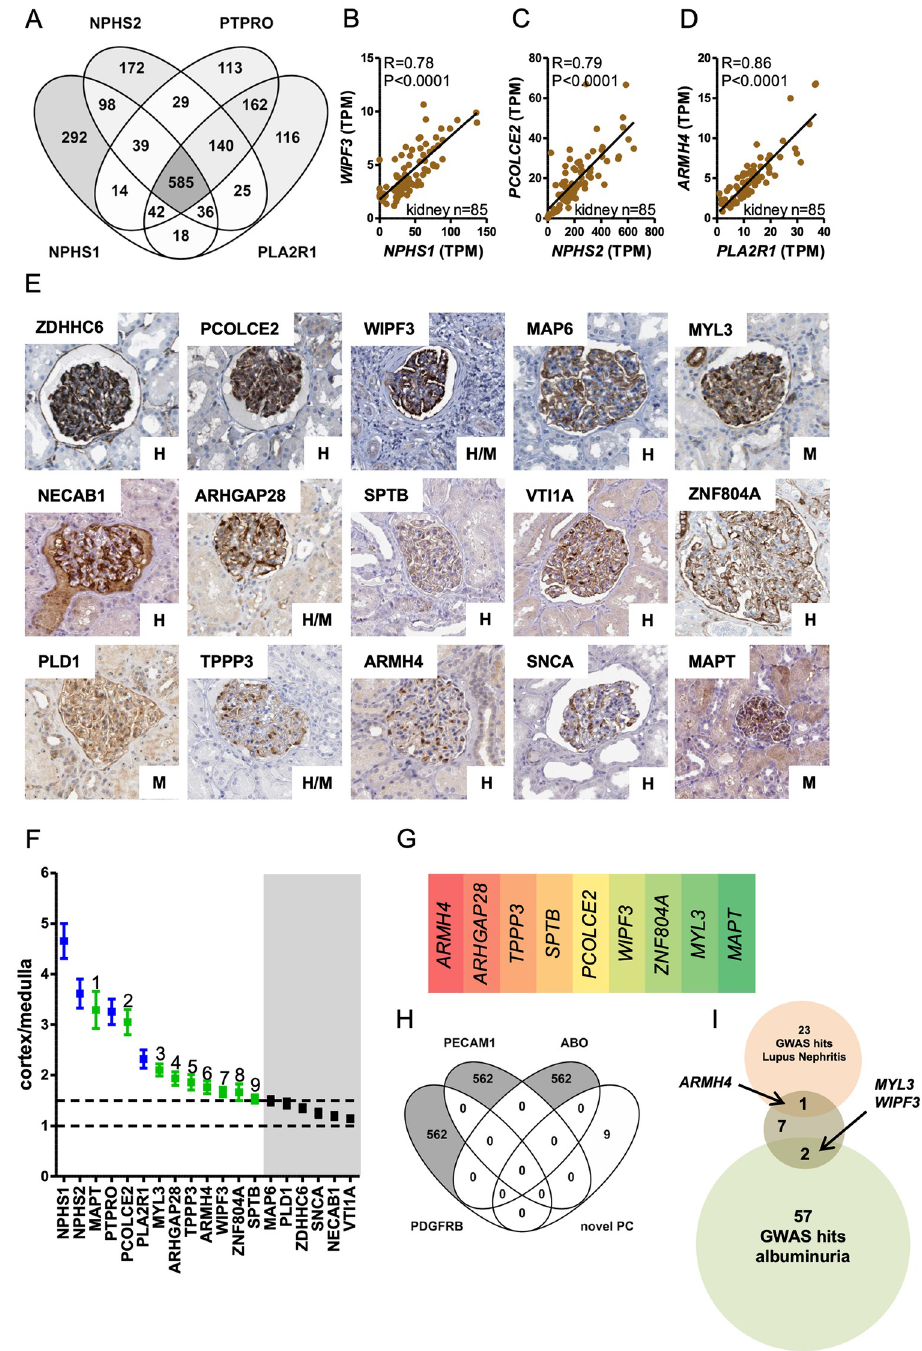
Fig 1. A multi-step computational strategy identifies human podocyte markers. NPHS1 , NPHS2 , PTPRO , and PLA2R1 were correlated with all other transcripts in kidney cortices from 85 individuals. A : overlay of 585 transcripts obtained by cross-referencing the top-ranking 1124 transcripts (2%) from each analysis. B—D : correlations between NPHS1 and WIPF3 , between NPHS2 and PCOLCE2 , and between PLA2R1 and ARMH4 . P values, Spearman Rho coefficients, and n values are shown in the panels. E : immunohistochemical staining (brown) for 15 gene products with evidence of a glomerular staining pattern in the Human Protein Atlas [22]. F : fold enrichment of the mean number of reads (in transcripts per million) in the cortex ( n = 85) versus medulla ( n = 4) for each of the 15 transcripts. G : the nine transcripts enriched in cortex > 1.5-fold in order of correlation strength vs. the four podocyte markers in panel A. H : overlay of the nine markers with top-ranking (1%) transcripts from correlations with mesangial cell (PDGFRB) ,